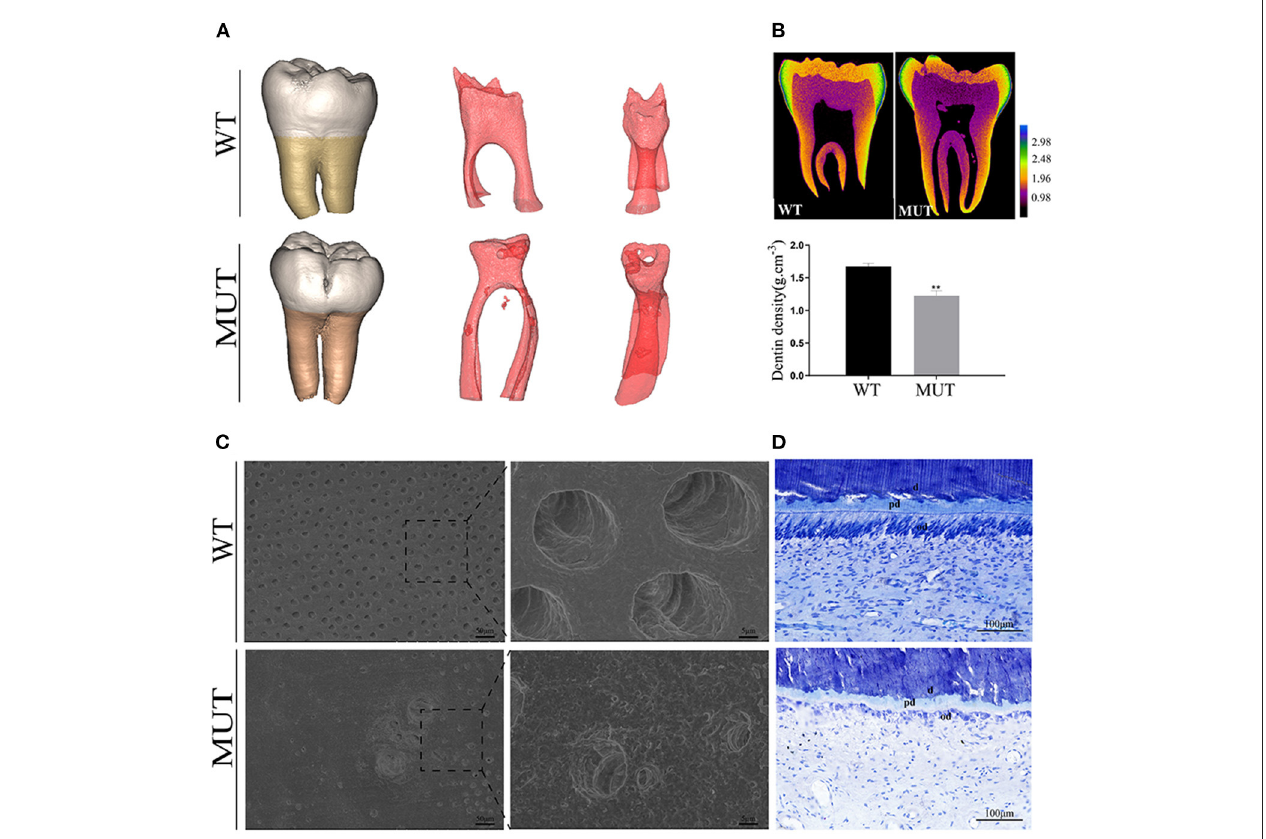
FIGURE 2 | Teeth ultrastructural analyses. (A) 3D reconstruction of the teeth CT data. 3D reconstruction of the pulp chambers. (B) Typical CT sections of the teeth are presented using false colors calibrated based on the mineral density to generate mineral density maps. (C) SEM of representative exfoliated teeth. The SEM images of the control dentine showed regularly organized dentine tubes and an evenly calcified matrix, while the teeth of the patients with DGI-I presented very few dentine tubules and enlarged malformed dentine tubes. (D) Toluidine blue staining of teeth. The number and morphology of odontoblasts adjacent to the mineralized dentine layer were visibly different. d, dentine; od, odontoblast; pd,